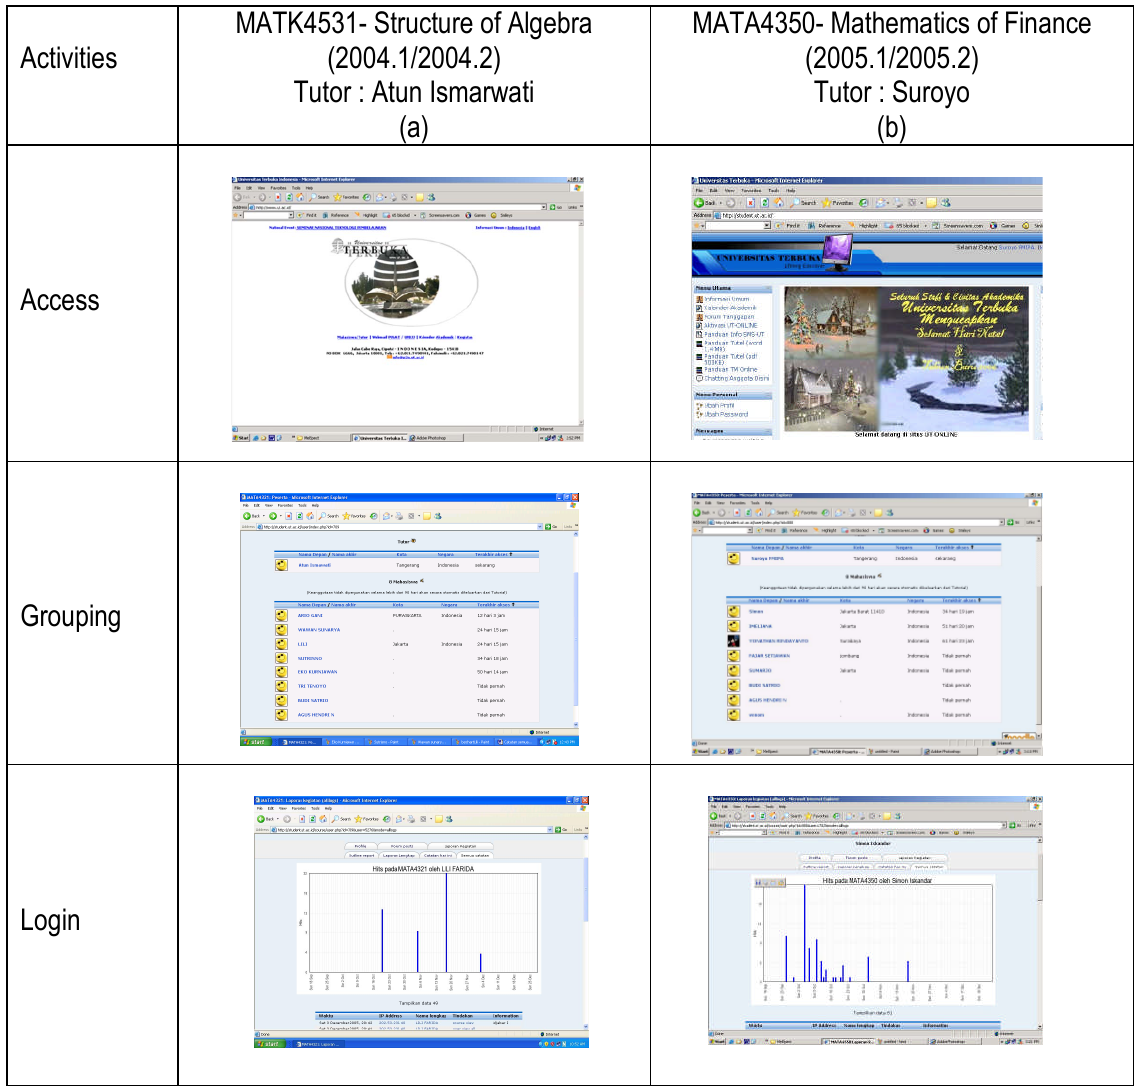
Figure 2. Students Activities in Tutorial Online for MATA4321-Structure of Algebra (2004.1/2004.2) and MATA4350- Mathematics of Finance (2005.1/2005.2) in the Department of Mathematics at